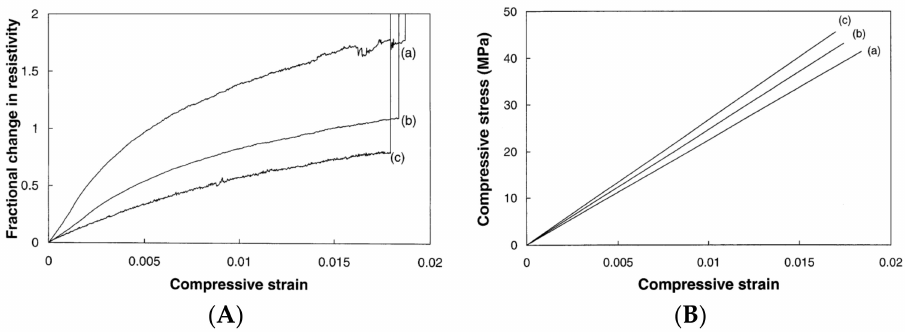
Figure 12. Strain during compressive testing up to failure at loading rates of (a) 0.144, (b) 0.216 and (c) 0.575 MPa/s versus ( A ) fractional change in resistivity and ( B ) stress. Reproduced with permission from [63], Elsevier,